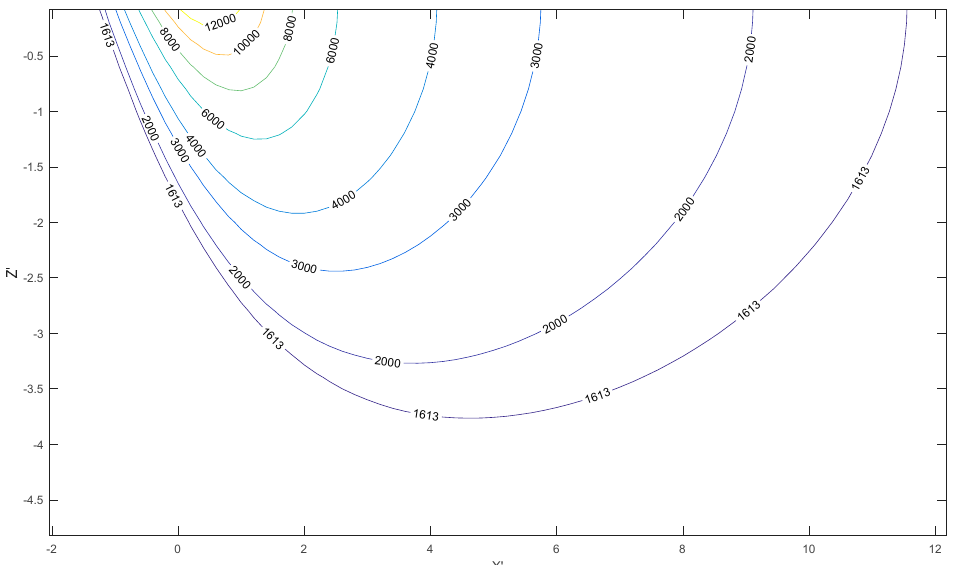
Figure A2. Melt pool temperature contour at longitudinal view for In718 with a laser power of 100 W, scanning speed of 1 mm/s, laser spot radius of 50 μ m and A = 0.5.